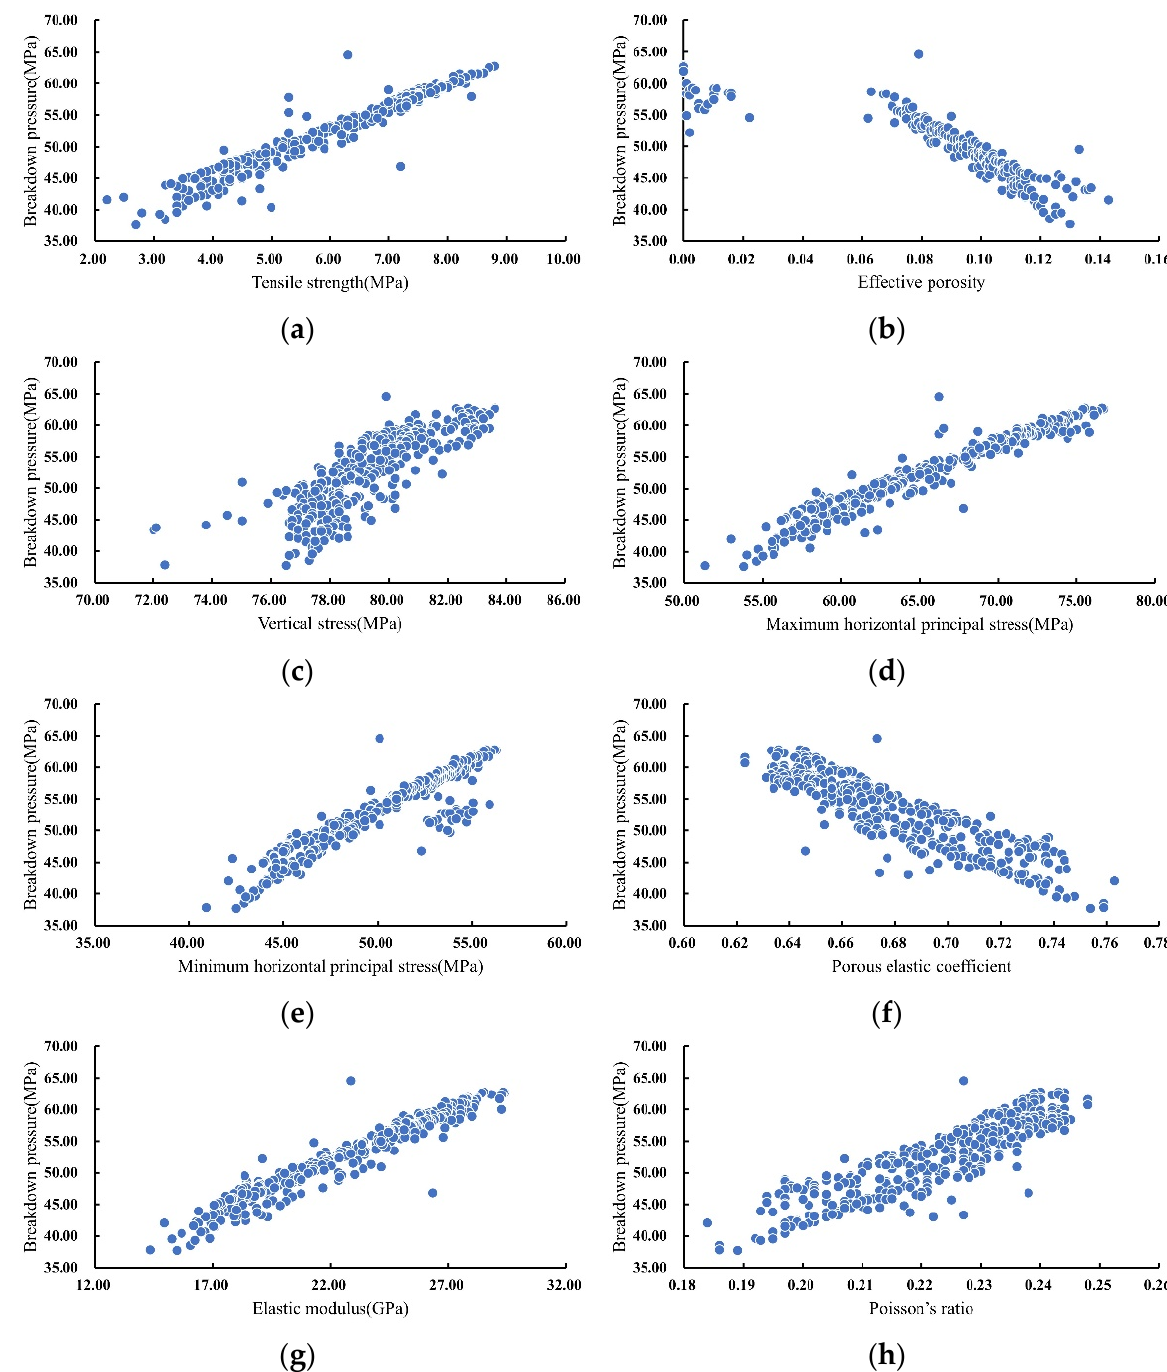
Figure 8. Correlation scatter diagram of the influential factors regarding cased hole breakdown pres- sure. ( a ) Tensile strength–breakdown pressure. ( b ) Effective porosity–breakdown pressure. ( c ) Vertical stress–breakdown pressure. ( d ) Maximum horizontal principal stress–breakdown pressure. ( e ) Minimum horizontal principal stress–breakdown pressure. ( f ) Porous elastic coefficient–breakdown pressure. ( g ) Elastic modulus–breakdown pressure. ( h ) Poisson’s ratio–breakdown pressure.